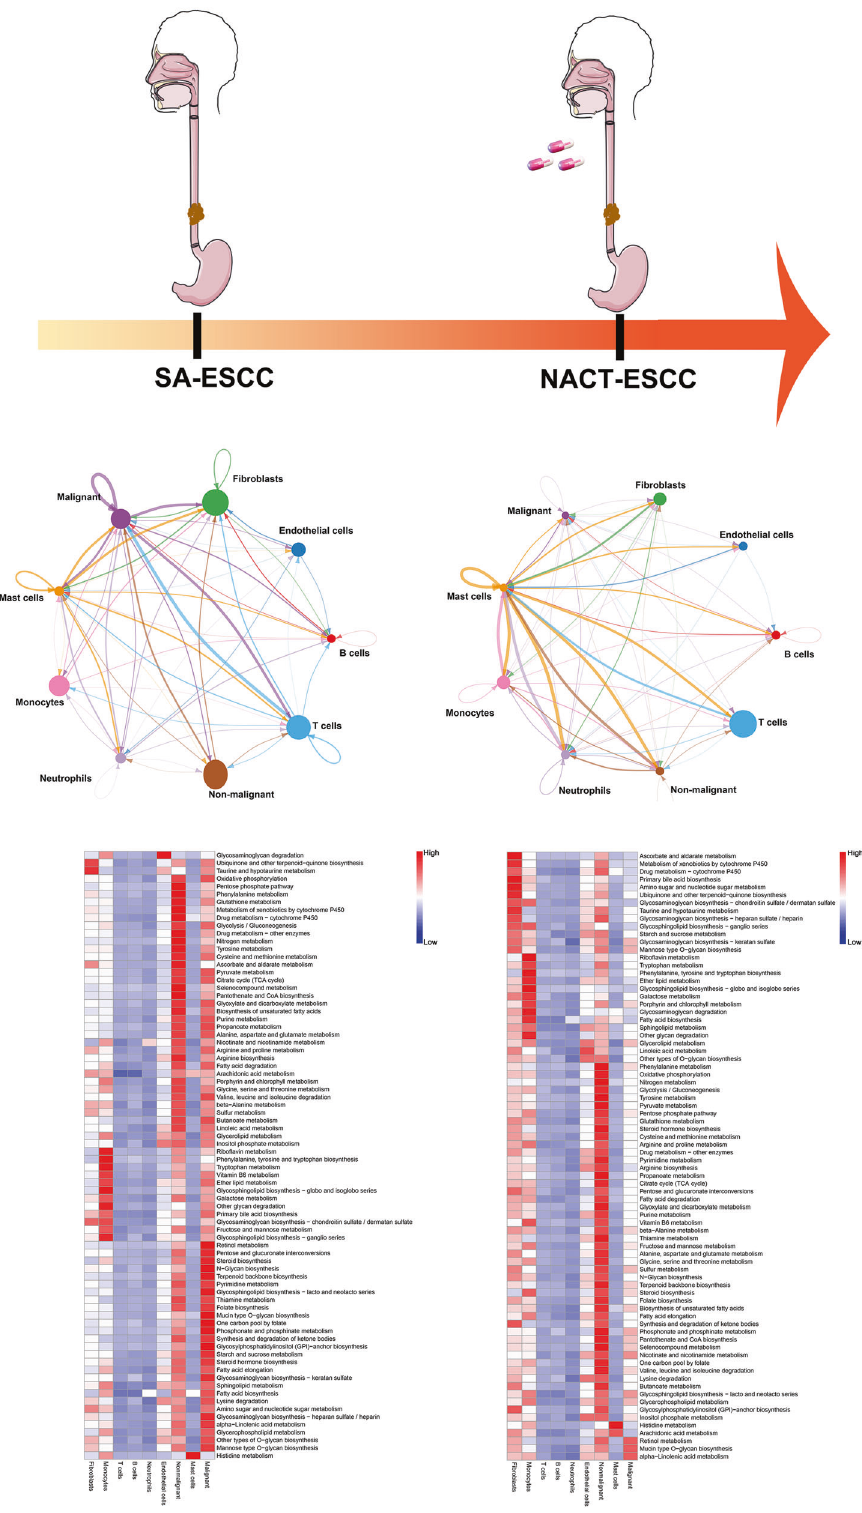
Fig. 3 The single-cell transcriptome network underlying SA-ESCC and NACT-ESCC conditions. Cellular and molecular changes from SA- ESCC to NACT-ESCC. Top: The cell-cell communication networks constructed using CellPhoneDB. The nodes stand for each epithelial cell type in SA-ESCC and NACT-ESCC tissue, and the thickness of edges in the network denotes the correlation coef fi cient between each cell type. Bottom: Epithelial cell type-speci fi c metabolic reprogramming based on scRNA-seq data under SA-ESCC and NACT-ESCC